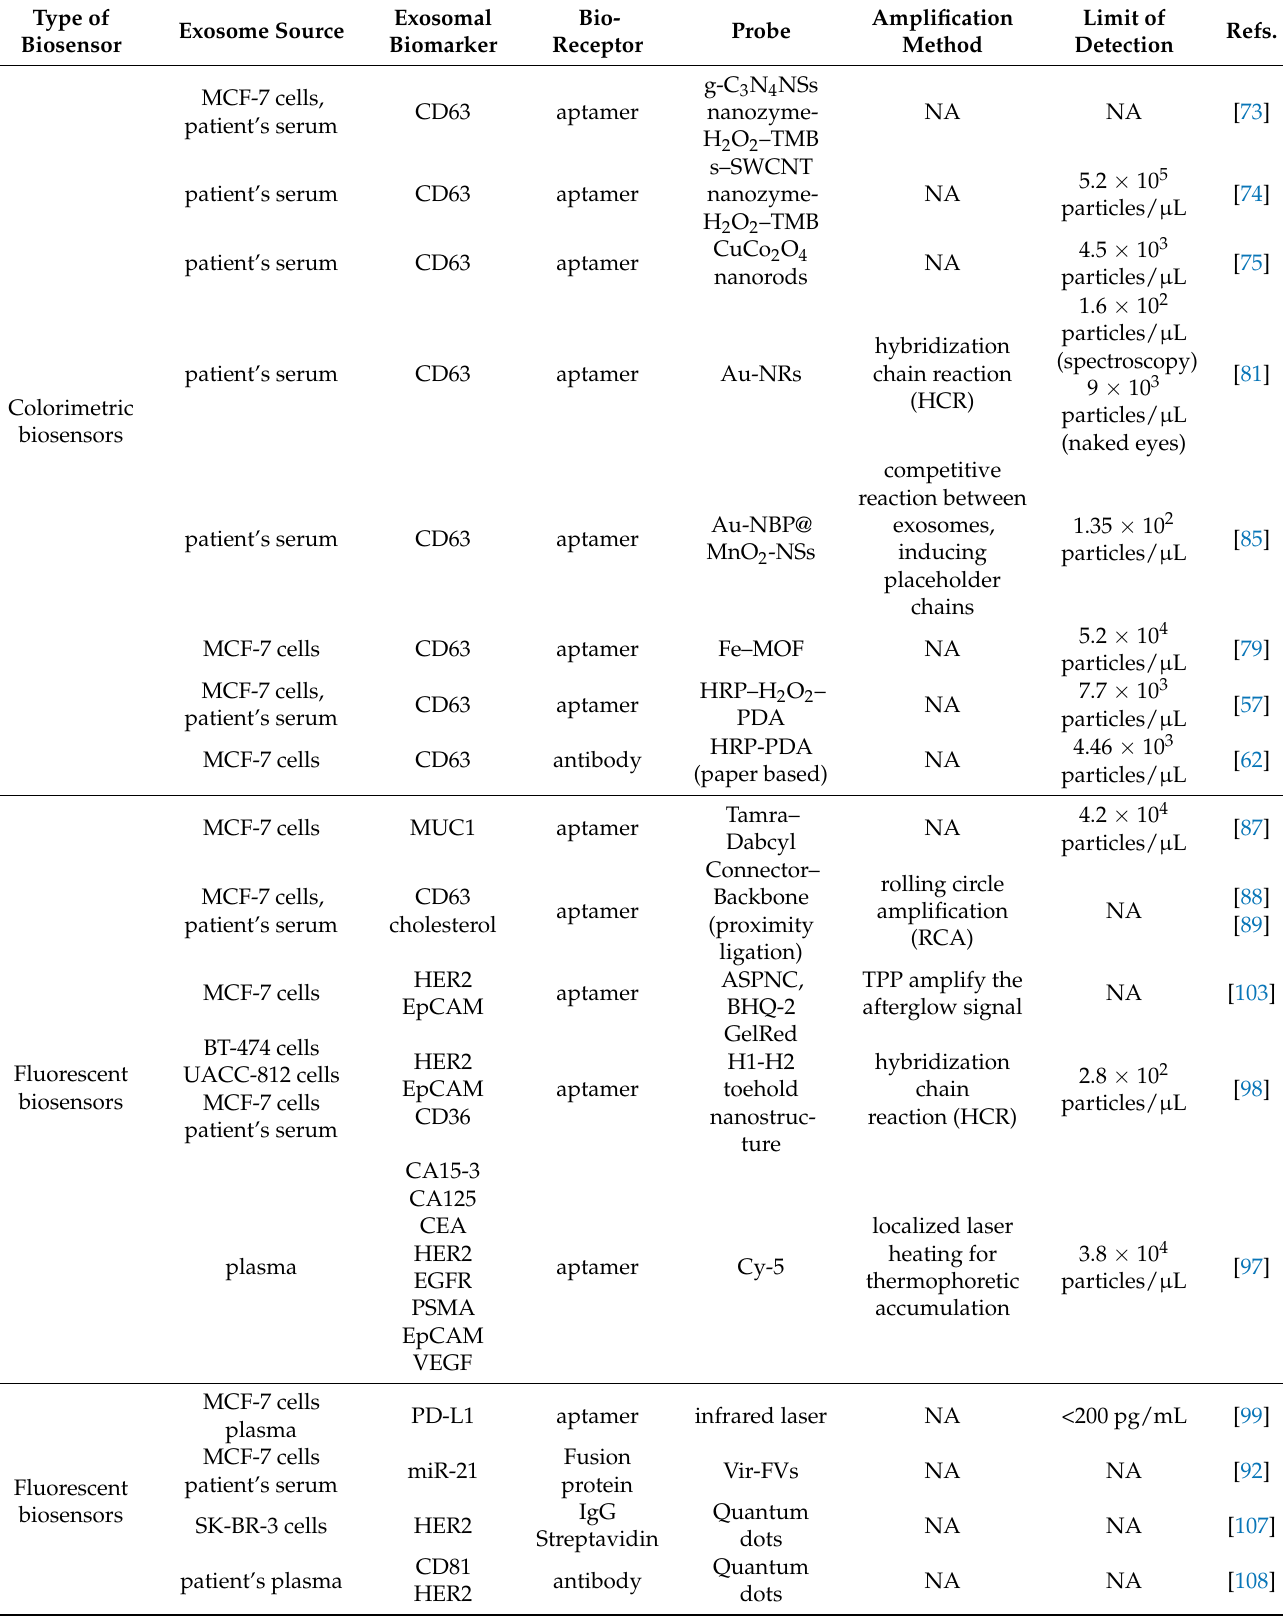
Table 2. Comparison and summary of various methods for the detection of exosomes.